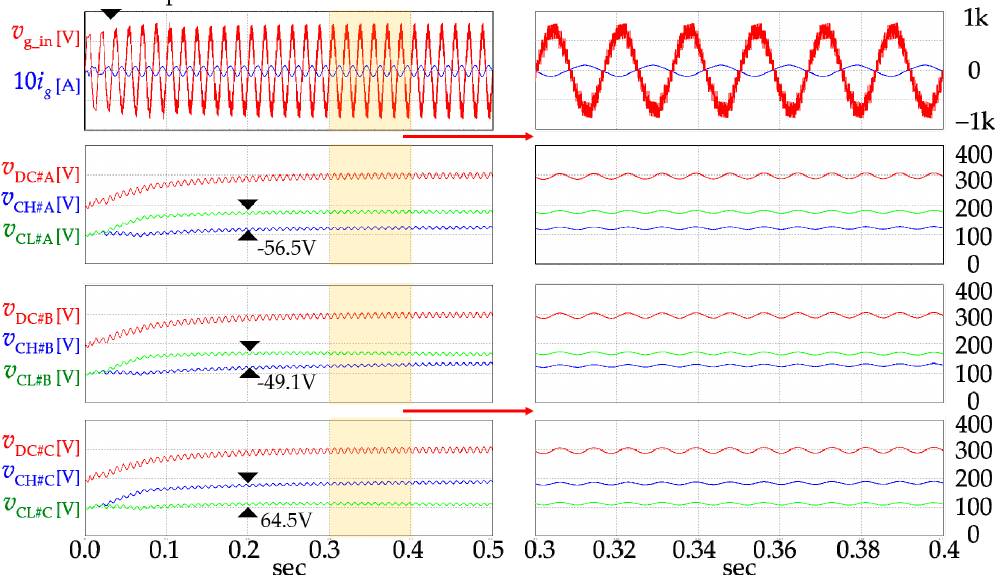
Figure 5. DC-link voltage control of multi-module NPC inverter without voltage balancing control.